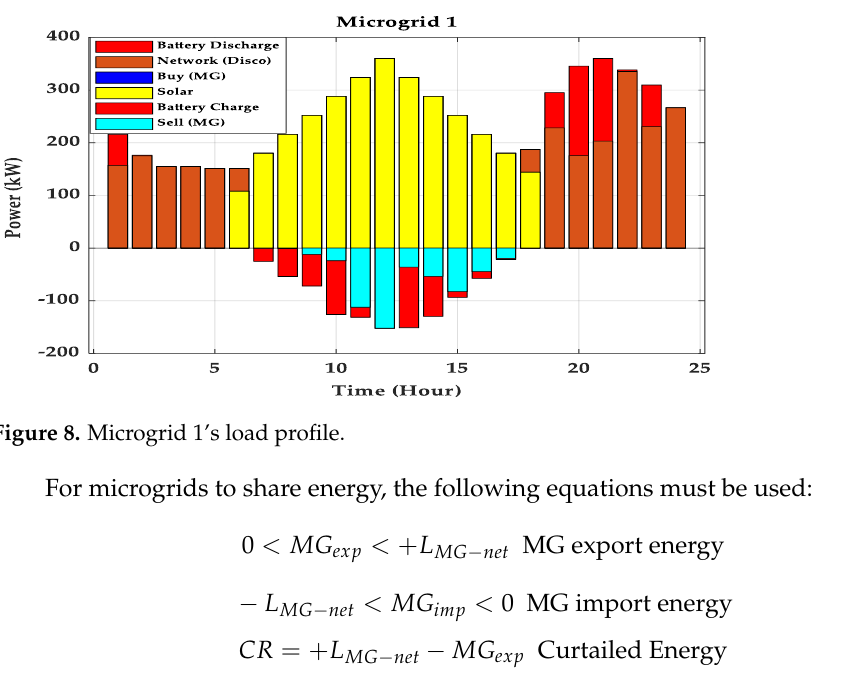
Figure 8. Microgrid 1 ’s load profile.